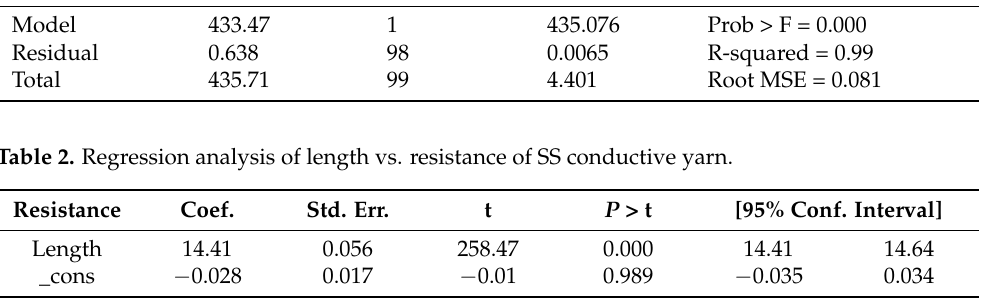
Figure 5. Length-dependent resistance of stainless steel conductive yarn.